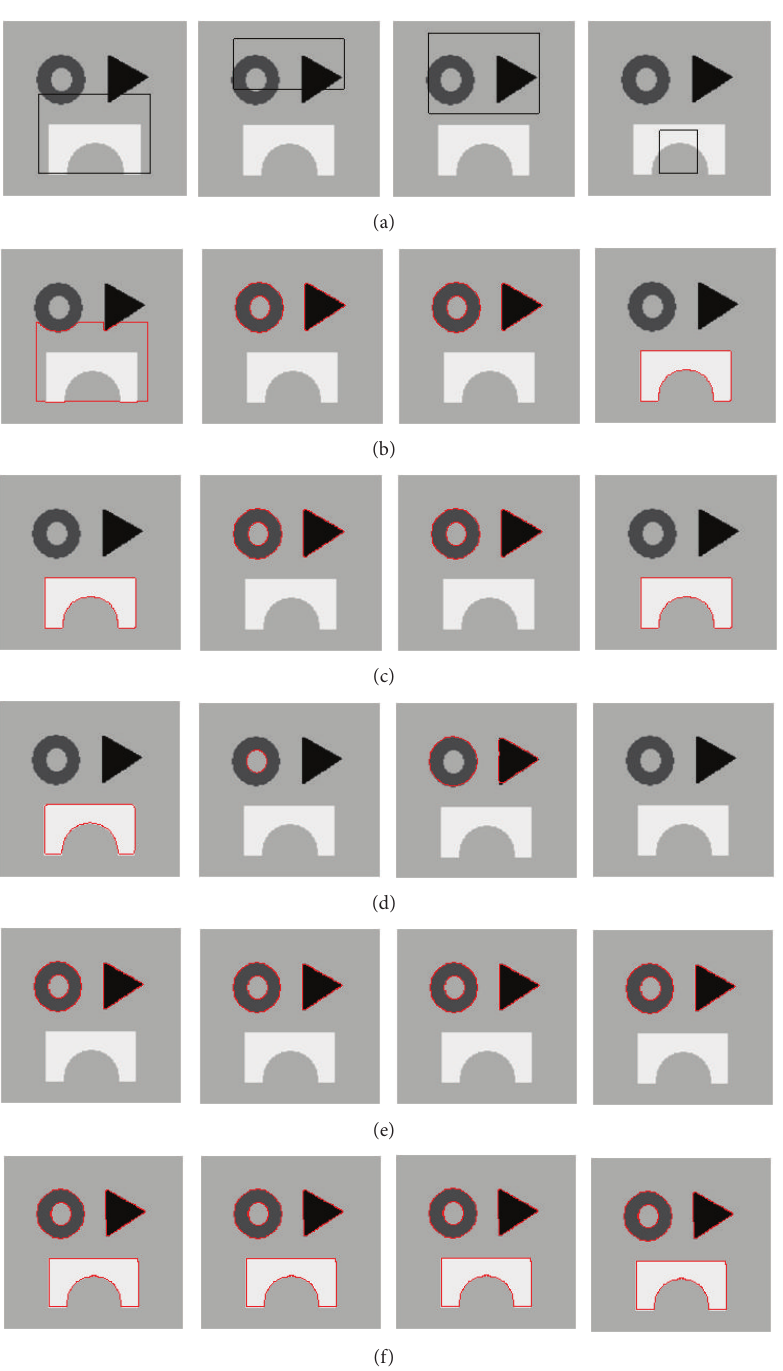
Figure 17: Detection of different objects from a synthetic image with various initial conditions: (a) the four different initial contours, (b) the CV model results of the corresponding initial conditions, (c) the GACV model results of the corresponding initial conditions, (d) the DRLSE model results of the corresponding initial conditions, (e) the FAC model results of the corresponding initial conditions, and (f) the LFAC model results of the corresponding initial